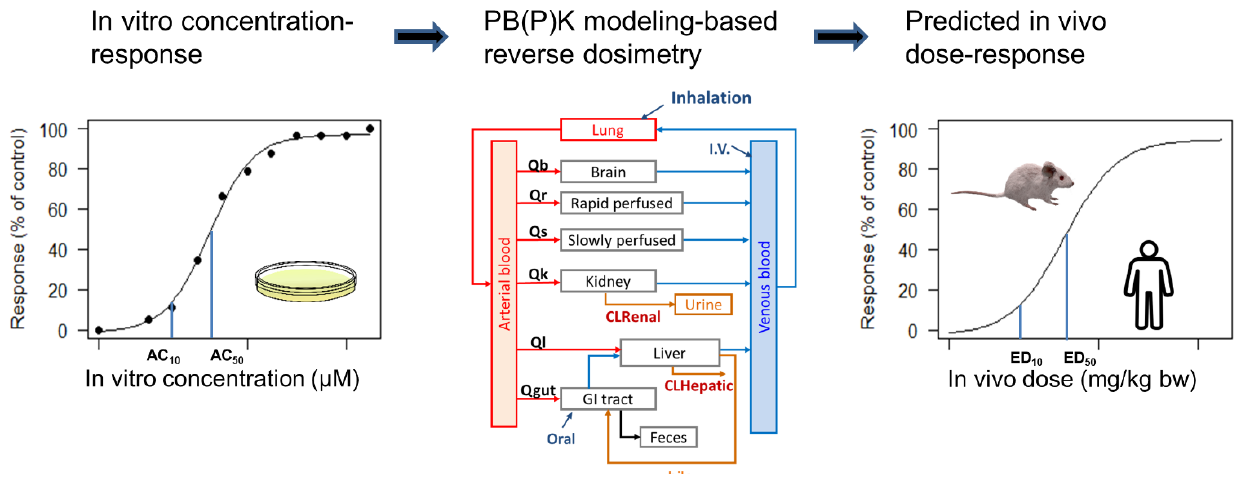
Figure 2. The process of IVIVE of dosimetry, figure adapted from Louisse et al.